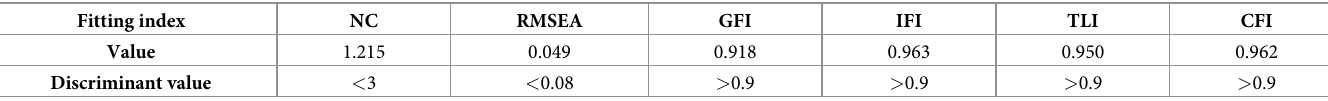
Table 13. The second -order model fit of